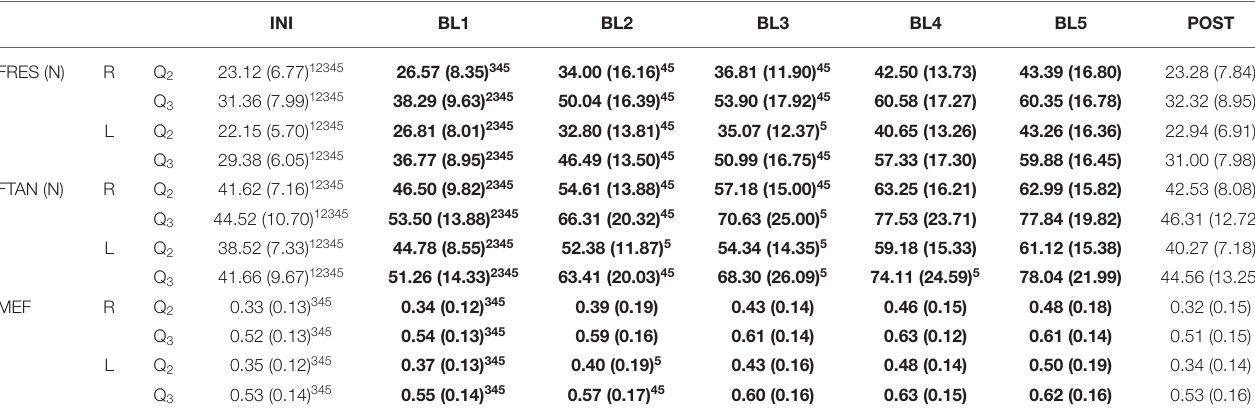
TABLE 2 | Average (1 SD) bilateral resultant force at the pushrim (Fres), tangential (Ftan) force component in Newtons, and mechanical effective force (MEF) during Q 2 and Q 3